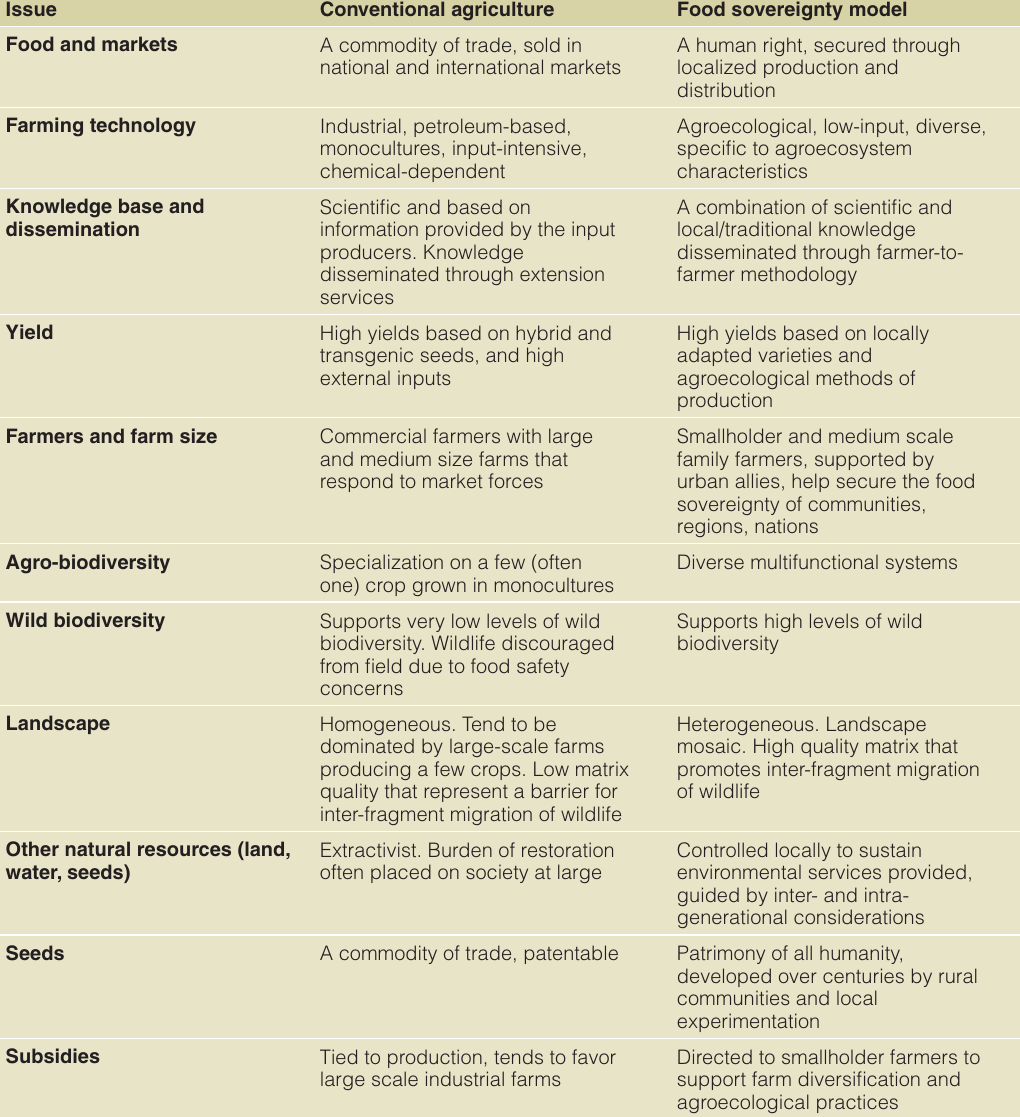
Table 1. Conventional agriculture vs Food sovereignty model (adapted from Reardon and Pérez (2010) 227 and Rosset (2003) 228